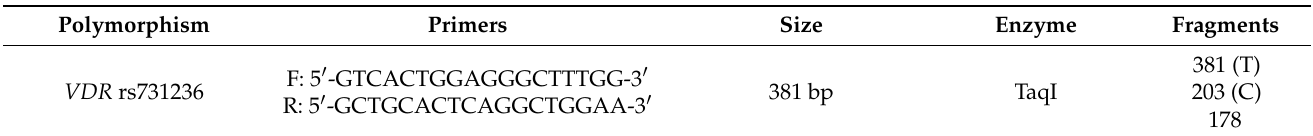
Table 2. Sequence of primers and restriction fragments. Primers and restriction enzymes used for the investigation for the VDR rs731236 gene